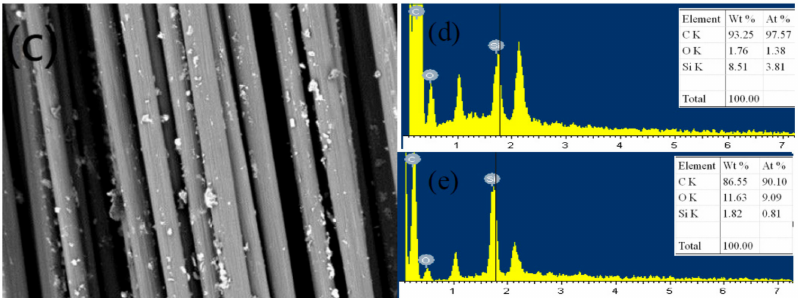
Figure 2. ( a ) SEM image of the bare, ( b ) SEM image of deposition time of 30 s and spraying distance of 15 mm and ( d ) EDS analysis, ( c ) SEM image of deposition time of 30 s and spraying distance of 25 mm and ( e ) EDS analysis.